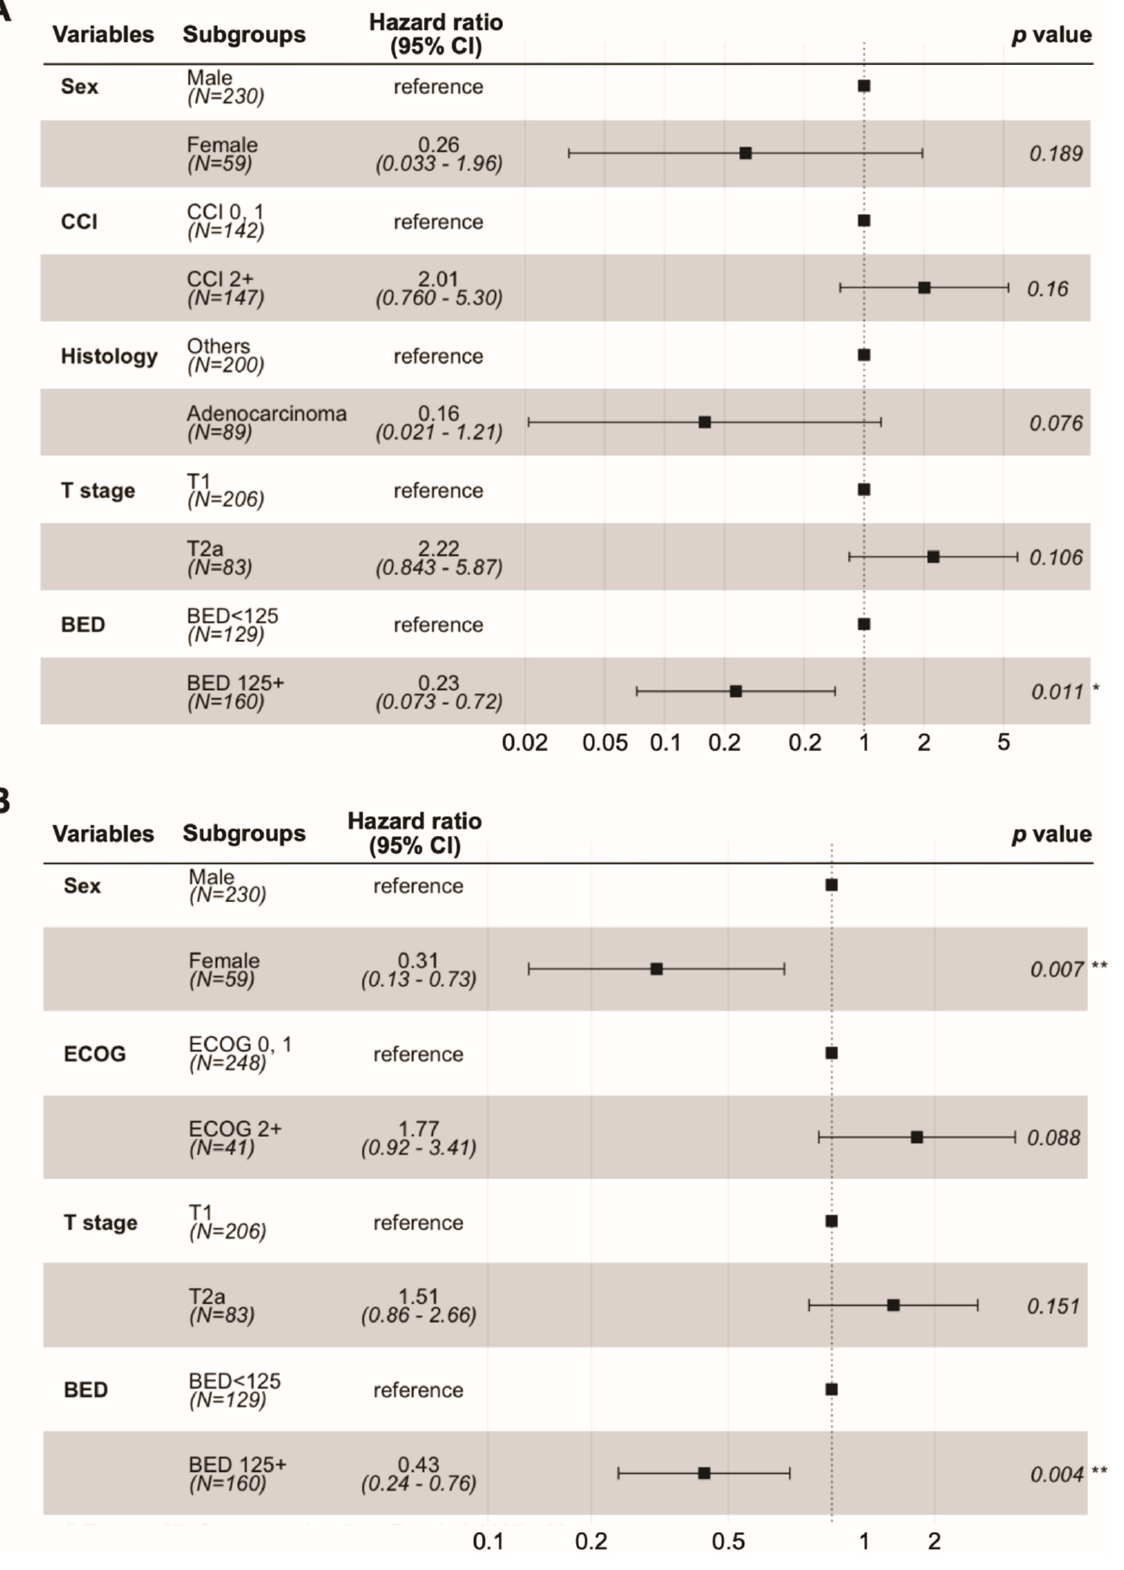
Figure 2. Forest plots of Cox proportional hazards regression model. Local progression-free survival ( A ). Overall survival ( B ). * <0.05; ** <0.01.